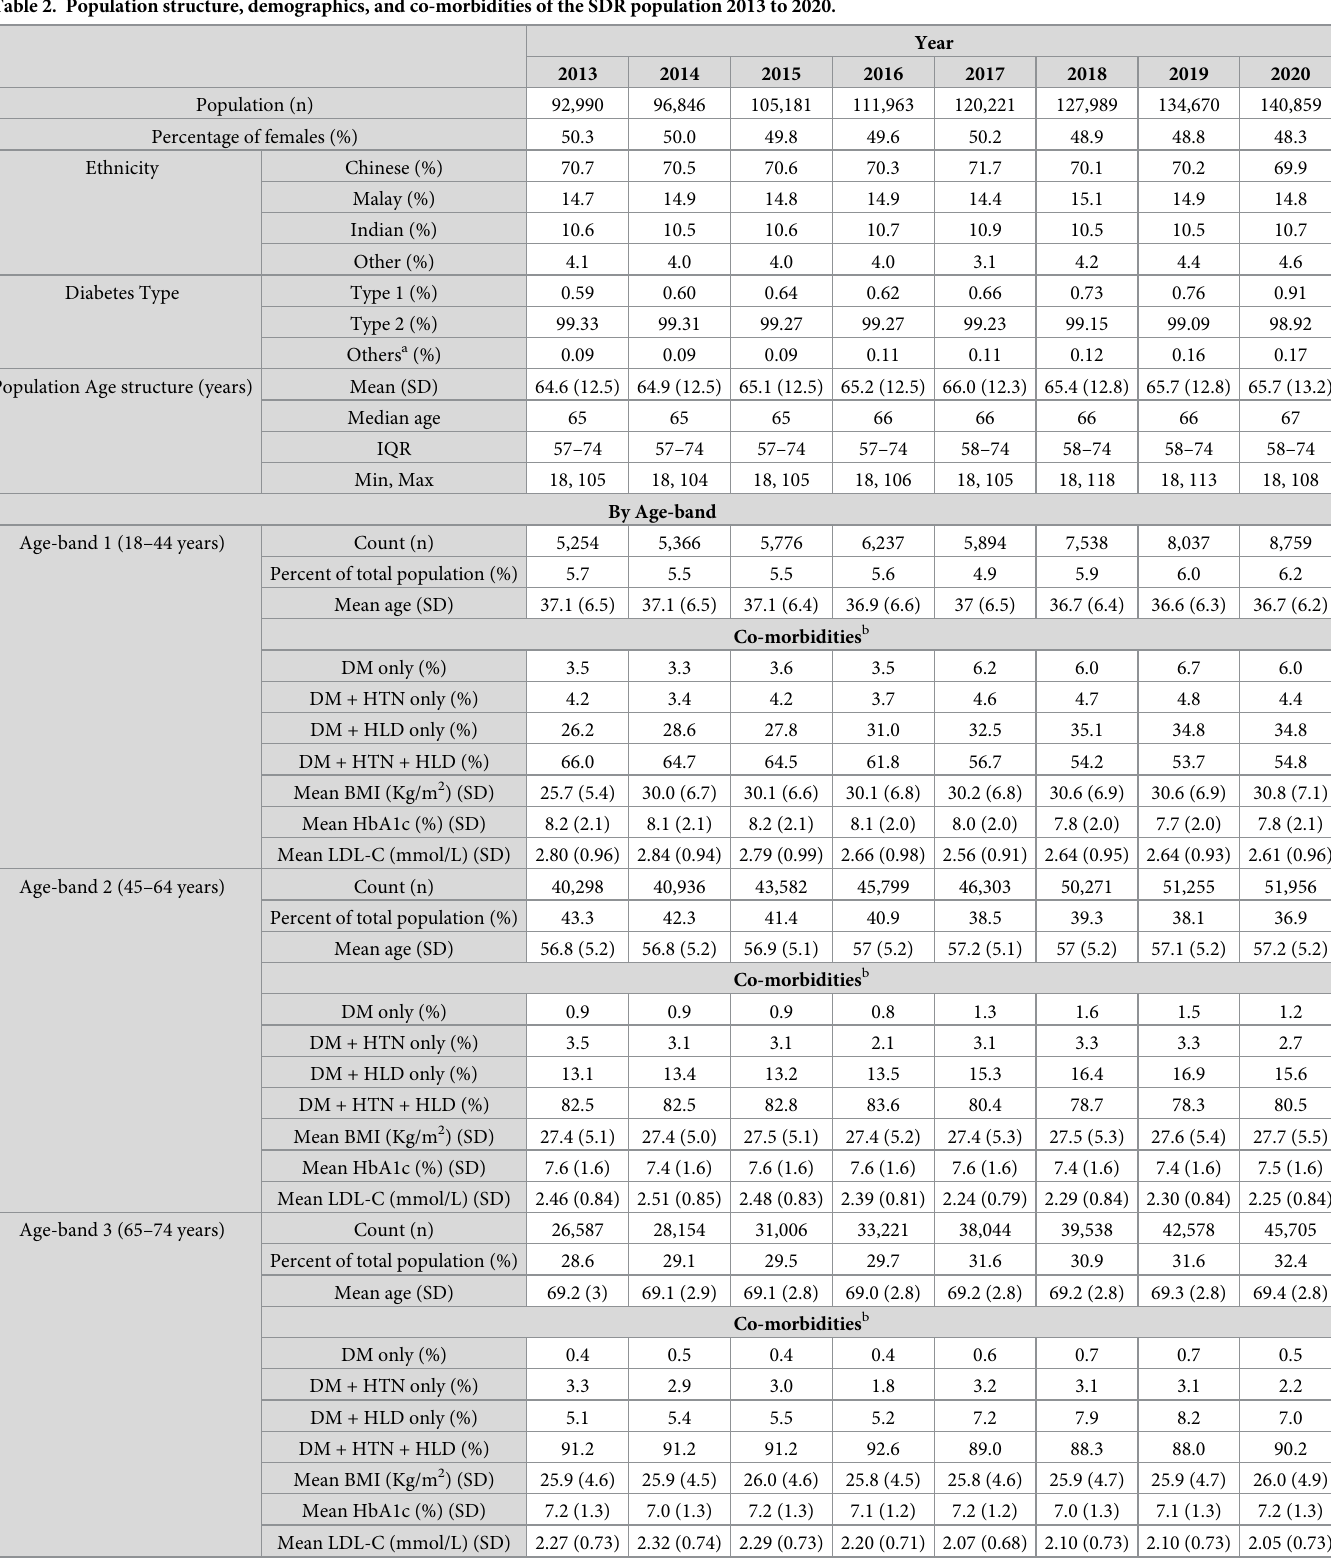
Table 2. Population structure, demographics, and co-morbidities of the SDR population 2013 to